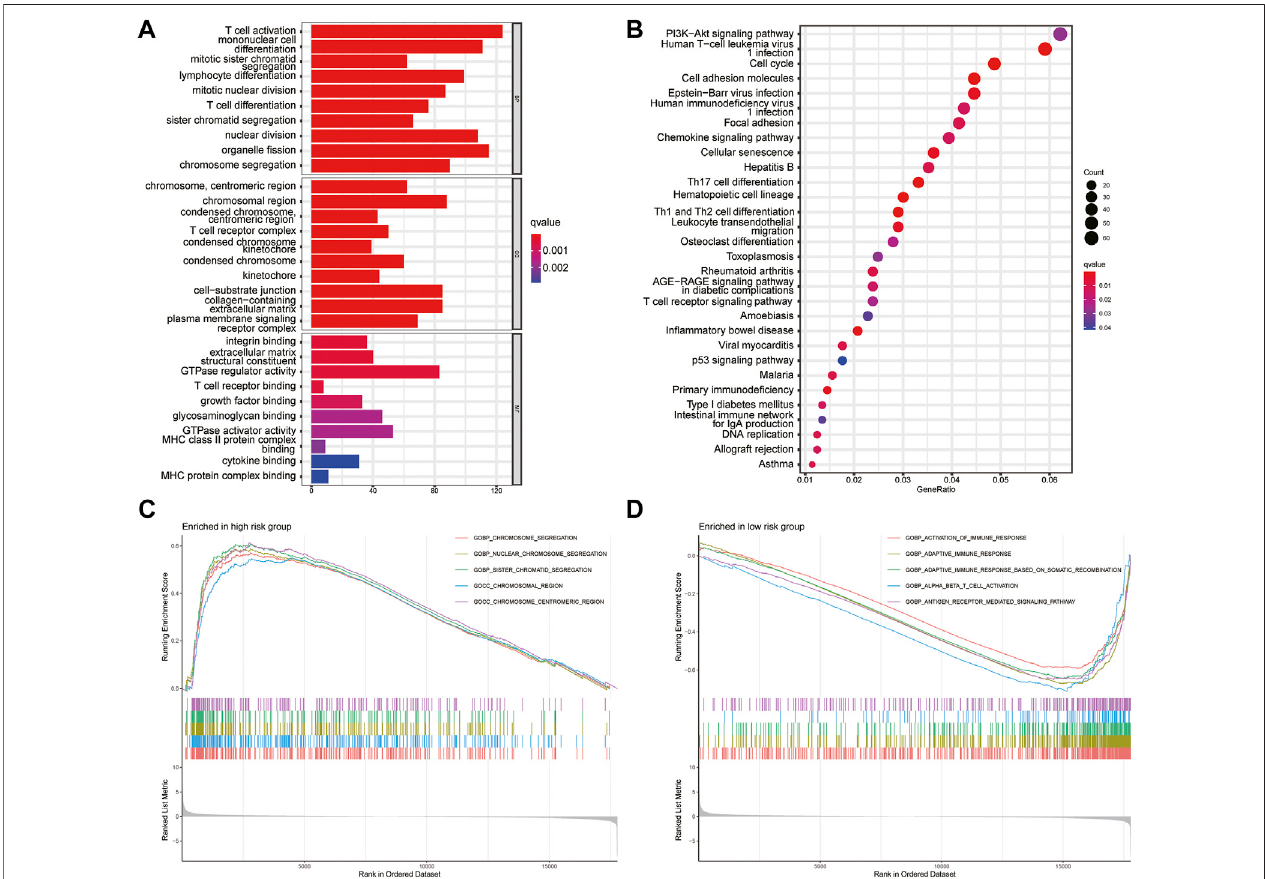
FIGURE 7 | Gene set enrichment analysis (A) GO analysis the fi rst 10 items about the enrichment of BP, CC and MF were shown in the bar chart (B) The top 30 terms of KEGG pathwaysenrichment were displayed in the bubble chart (C,D) Gene set and function enrichment analysis of differentially expressed genes between the high-risk group low-risk group. p < 0.05 and FC > 1.2 (or FC < 0.83) were set as the cut-off values.